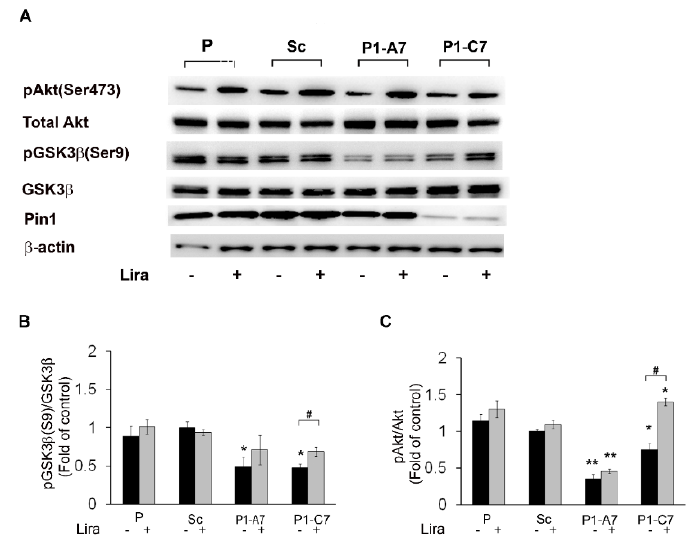
Figure 3. Lira restored protein expression level of GSK3β and Akt phosphorylated forms in Pin1 KD clones. ( A ) Representative western blots experiments of Pin1, pGSK3β(Ser9), GSK3β, pAkt(Ser473), and Akt expressions. ( B ) Quantitative evaluation of pGSK3β(Ser9) versus GSK3β expression. ( C ) Quantitative evaluation of pAkt(Ser473) versus total Akt expression. β-Actin expression levels were used as loading reference. Data are representative of three independent experiments and are shown as mean values ± SD. * p < 0.05; ** p < 0.01 vs Scramble clone. # p < 0.05 baseline versus treatment.